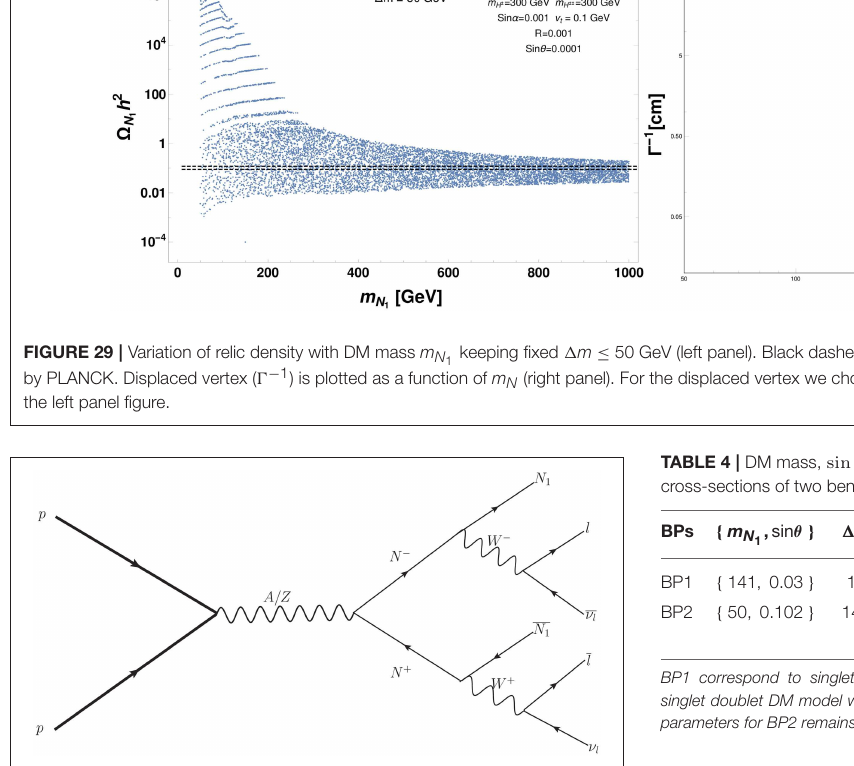
FIGURE 30 | Feynman diagram for producing hadronically quiet opposite sign dilepton plus missing energy ( ℓ + ℓ −